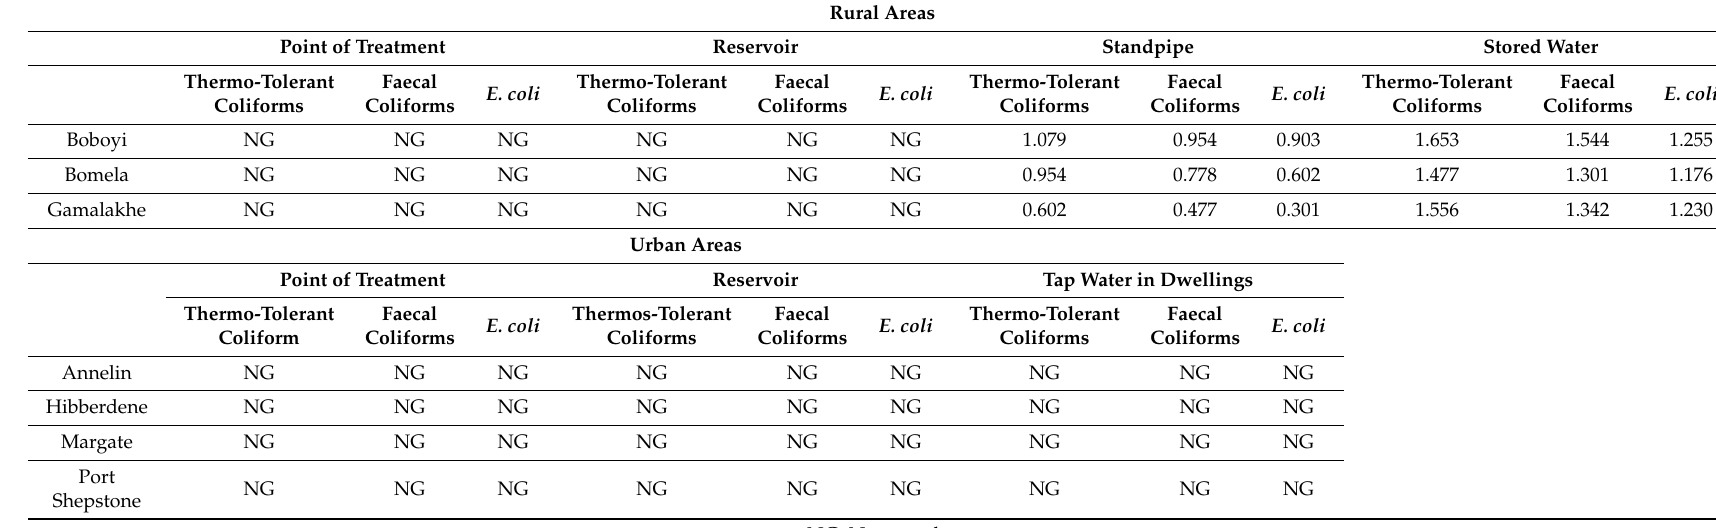
Table 5. Geometric mean concentration (log10 CFU / 100 mL) of presumptive E. coli and thermotolerant coliforms in Ugu District (2008–2009 and 2015). Rural Areas Point of Treatment Reservoir Standpipe Stored Water Thermo-Tolerant Faecal Thermo-Tolerant Thermo-Tolerant Faecal E. coli Coliforms Coliforms Coliforms Coliforms Coliforms